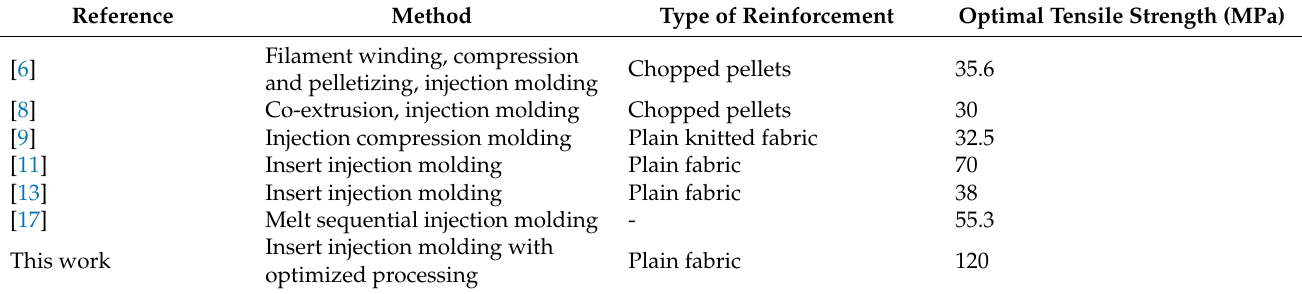
Table 3. Comparison of optimal tensile strength of PP SPC samples produced by different injection molding